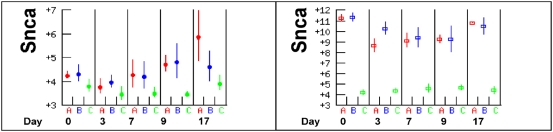
Expression of Snca in (A) liver and (B) spleen.
Snca is strongly associated with reticulocytes and was the gene with largest expression difference that correlated with anaemia response. The strong expression of Snca in the spleen of A/J and BALB/c is suggestive of extra medullary haematopoiesis in this organ in these strains.